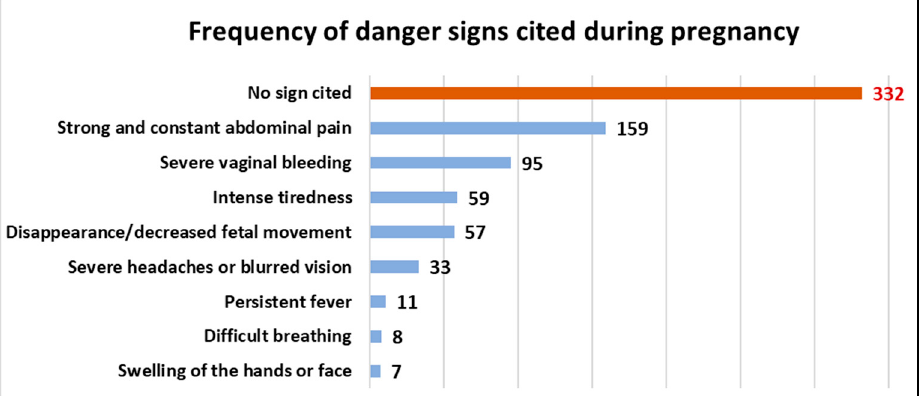
Figure 1. Frequency of ODS cited during antepartum.